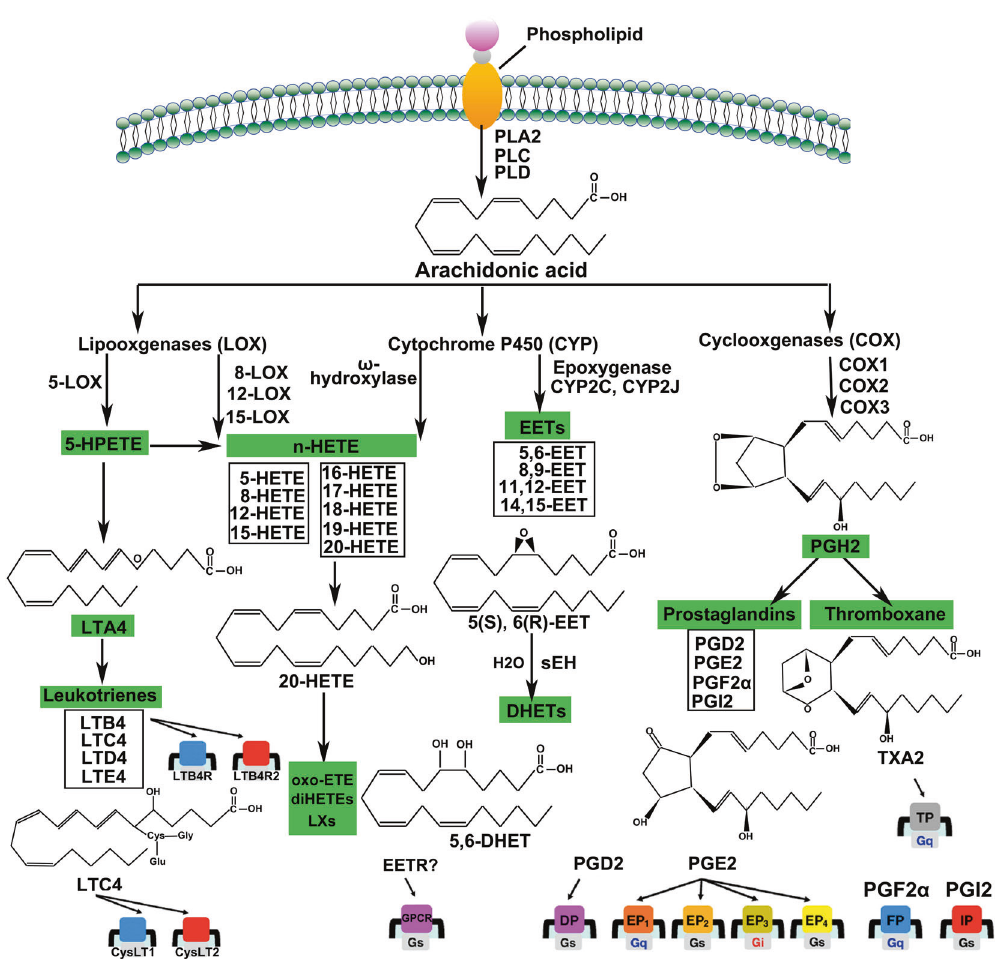
Fig. 1 Overview of the arachidonic acid (AA) metabolism pathways. Three major phospholipase enzymes (PLA2, PLC and PLD) are responsible for releasing AA from membrane-bound phospholipids by catalyzing the red arrow indicated covalent bonds, respectively. The PGHSs (COXs) metabolize AA to protanoids, prostacyclin, and thromboxane. The LOXs metabolize AA to leukotrienes and HETEs. The P450 epoxygenases metabolize AA to midchain HETEs and four EET regioisomers. All EETs are then further metabolized to less active dihydroxyeicosatrienoic acids (DHETs) by